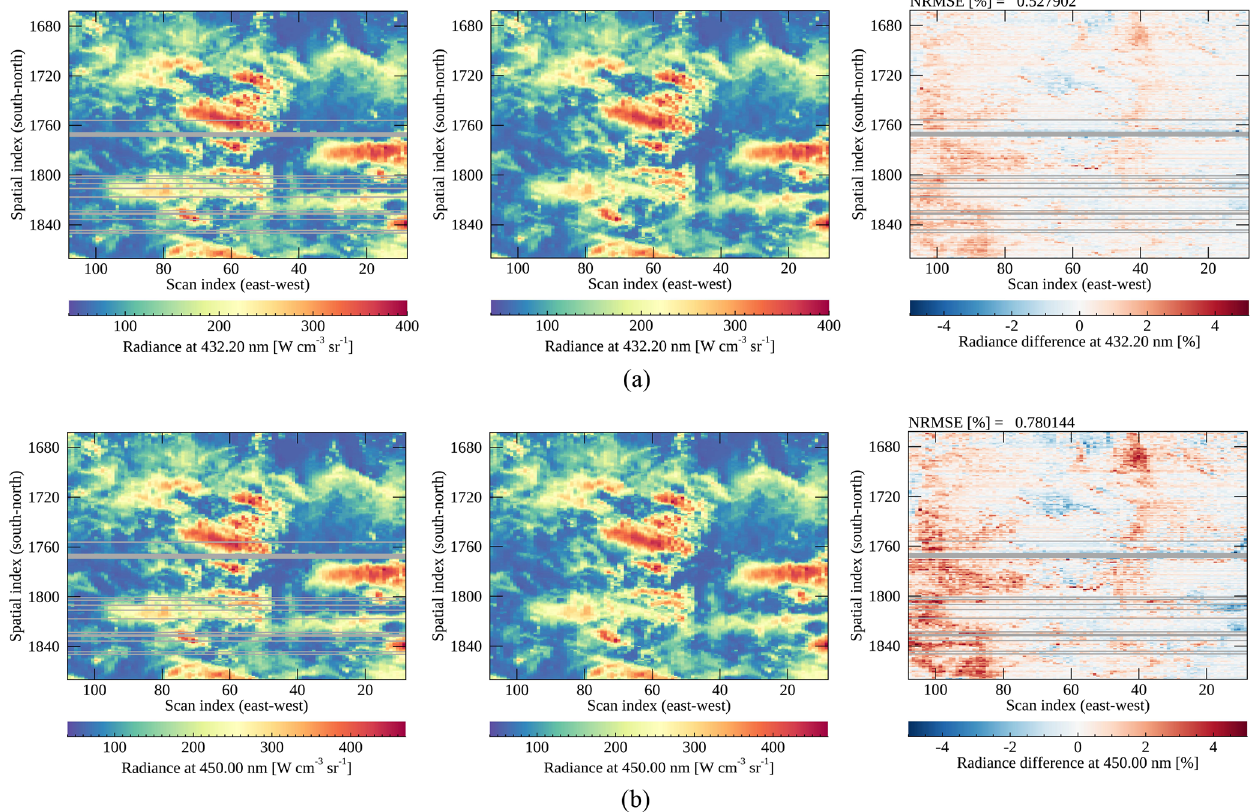
Figure 8. Same as Fig. 7 for the Defect 1 area with the color bar range for differences within ± 5%.